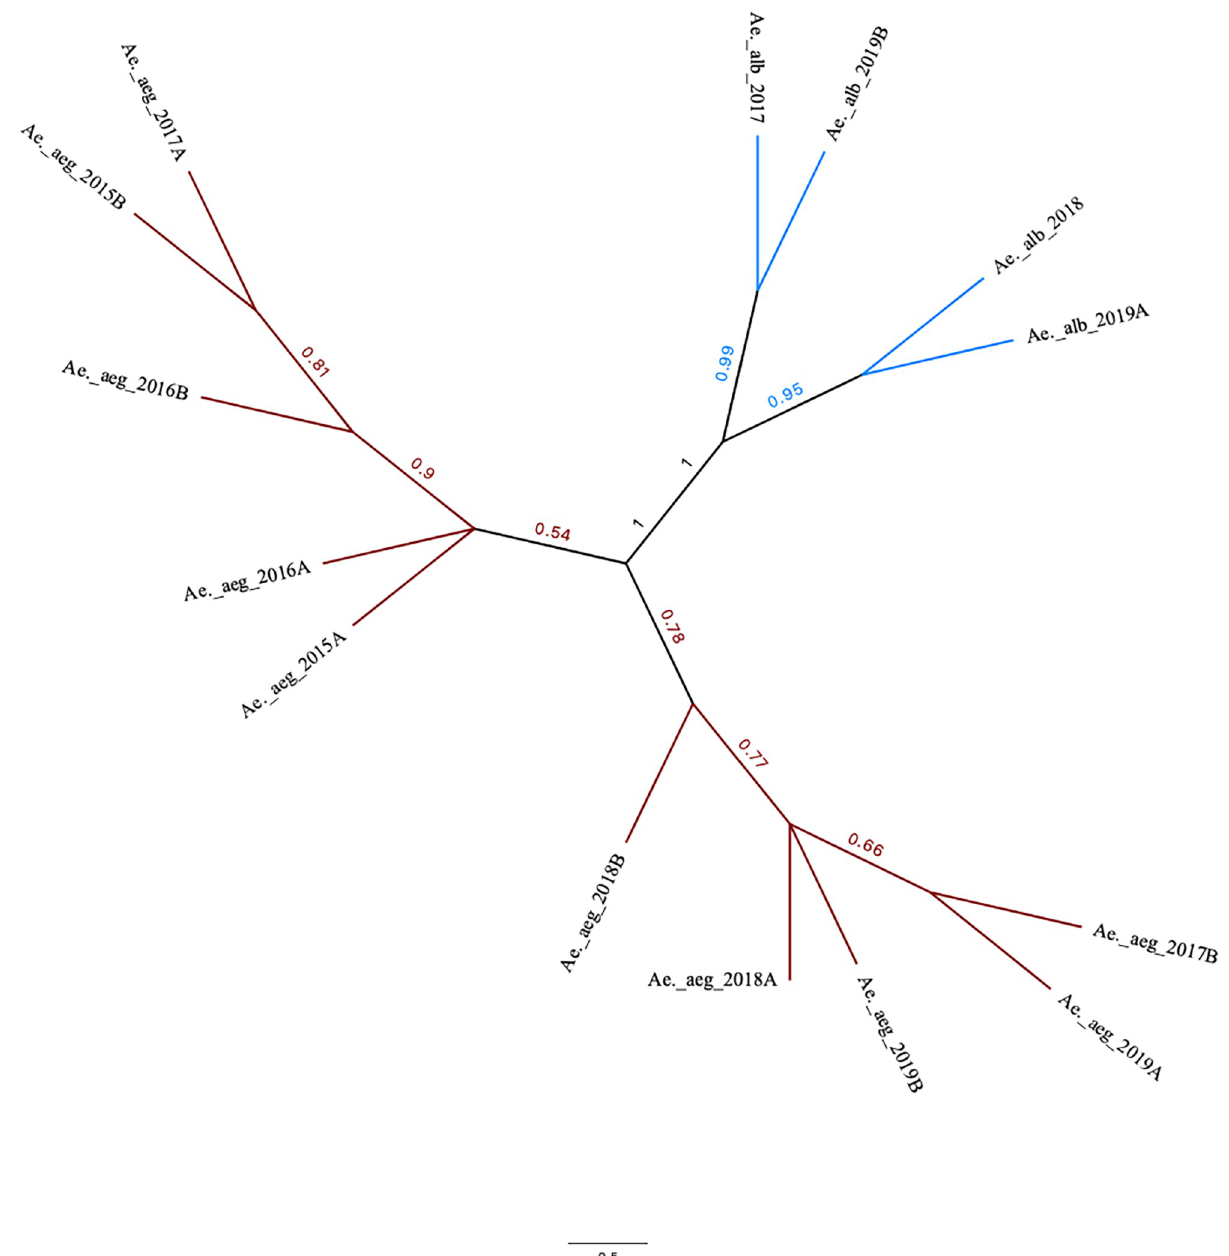
Fig 7. Distance-based tree based on mitochondrial sequences in Ae . aegypti and Ae . albopictus collected between 2015 and 2019 in Medellı´n, Colombia.